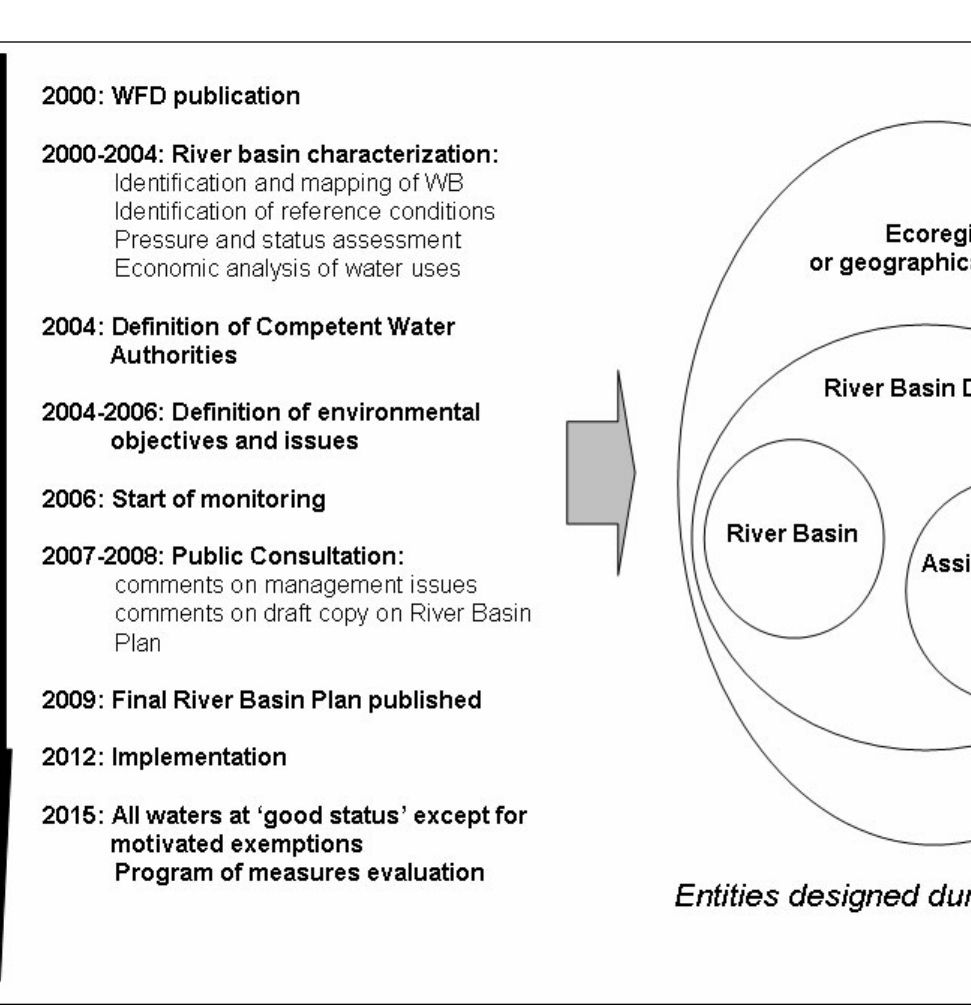
Fig. 1. The main steps and deadlines of the Water Framework Directive (WFD)